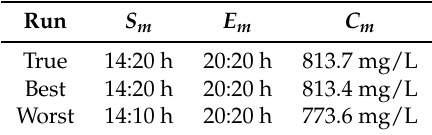
Table 3. Net3 network contamination event results comparison between true, best and worst of the total 30 runs.